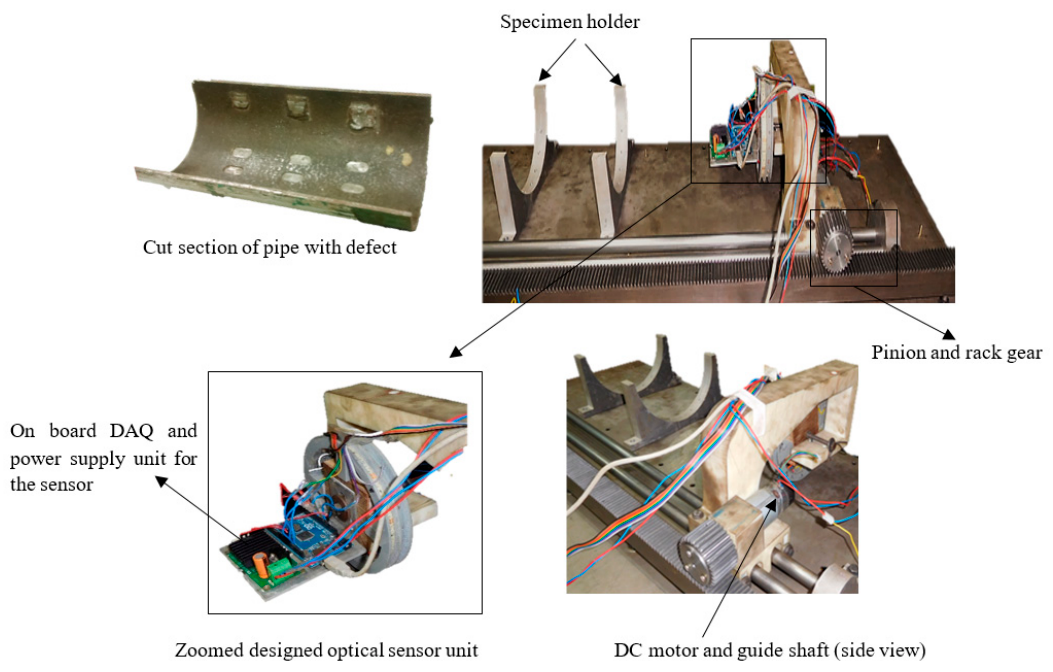
Figure 5. Picture of the self-designed laboratory testbed with different parts of the optical sensor array housing system, rack and pinion mechanism and the segmented pipeline.